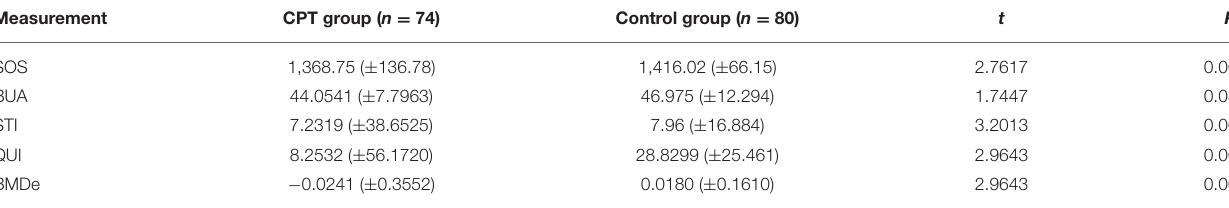
TABLE 5 | Associations of CPT differences parameters with age, gender, BMI and Crawford classification. Measurement Age Gender BMI Coef. P Coef. P Coef. Coef.